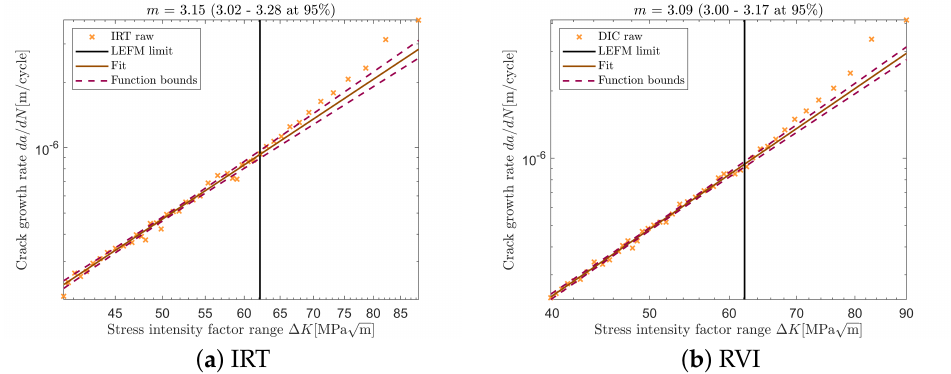
Figure 16. Crack growth curves and their linear fit for IRT ( a ) and DIC data ( b ). The vertical line represents the calculated linear elastic fracture mechanics limit according to the small scale yielding criterion.